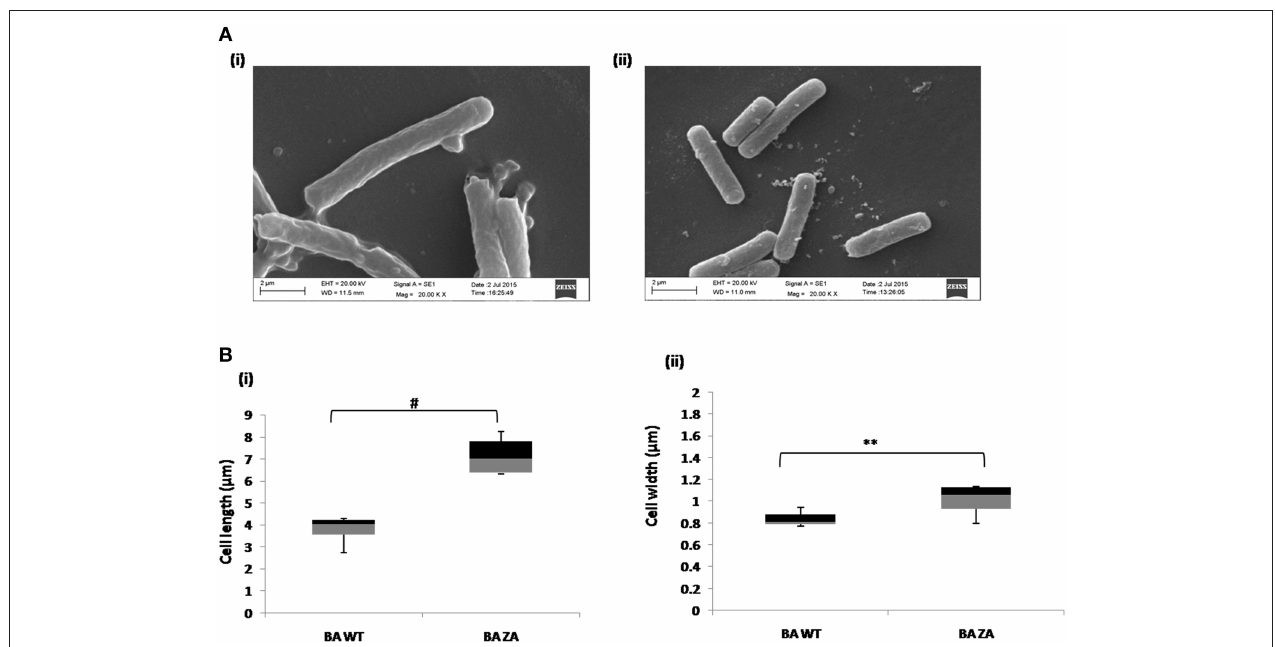
FIGURE 9 | Effect of ZA on morphology of B. anthracis. (A) Stationary phase cells from culture grown with (i) or without ZA (ii) were used for SEM analysis. (B) Box-and-whiskers plot to represent the cell dimensions where maximum and minimum size of population, median, and 25th and 75th population percentile is represented by whiskers, center bar, and each box, respectively. (i) cell length, (ii) cell width. ** indicates p ≤ 0.01 and # indicates p ≤ 0.001 .